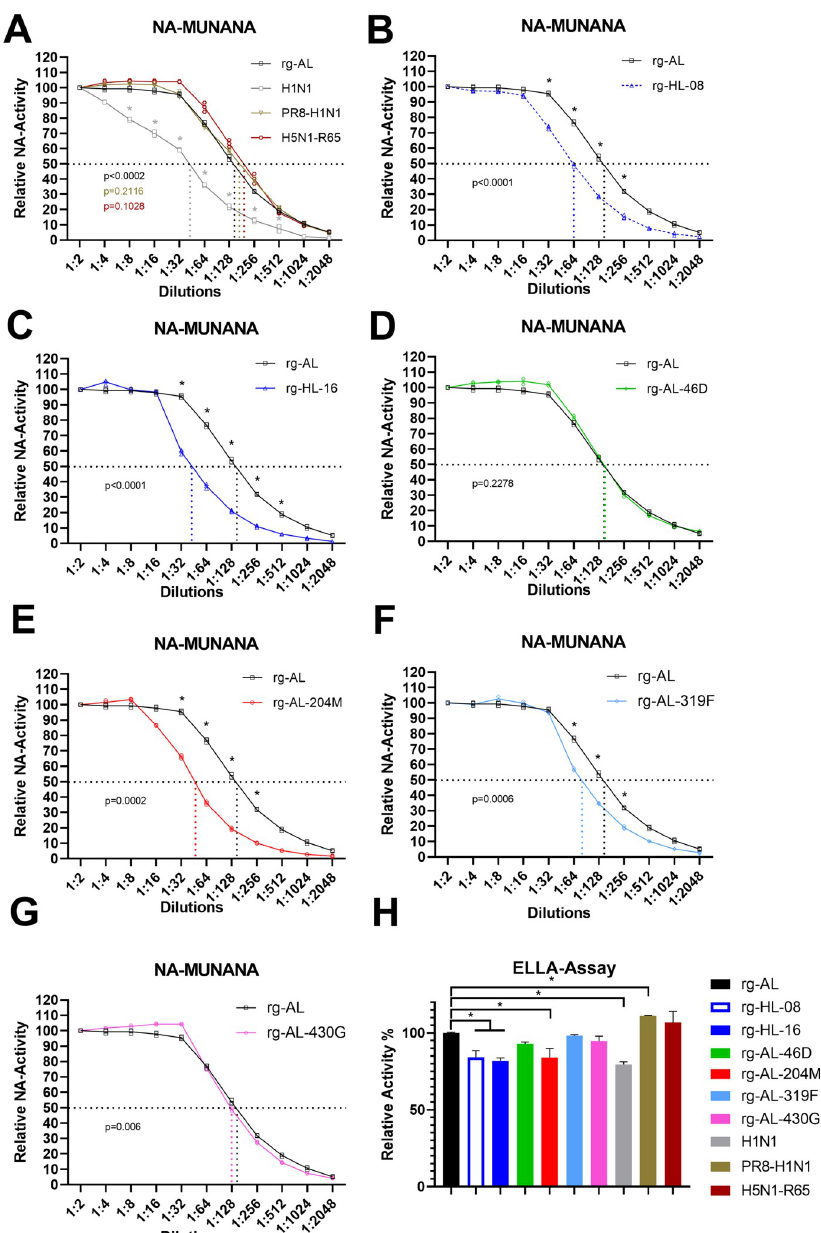
Fig 2. Impact of NA mutations on sialidase activity. Shown is the NA activity of Egyptian H5N1 viruses carrying different mutations against MUNANA (A-G) and fetuin (H). The experiments were done in three independent runs. The relative NA activity of different virus dilutions (y-axis) is compared to rg-AL (A-G). The p-values shown in the graphs refer to the statistical significance of the 50% NA-activity (shown as dashed lines) of indicated viruses compared to rg-AL (A-G). The activity of different viruses against fetuin in ELLA assay was calculated after adjustment of the absorbance (OD490) of rg-AL to 100%. The results are expressed as relative mean and standard deviation of three replicates (H). Asterisks refer to statistical compared to rg-AL at p value < 0.05. Viruses were adjusted to 32 HA units using chicken erythrocytes (and similar results were obtained after adjusting titers to plaque forming units). pattern for reduction of NA levels was observed with other NA subtypes, except N7 (S3A and S3B Fig).